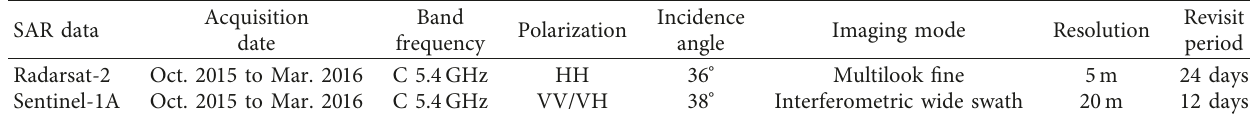
Figure 2: Wheat growth stage in Hebei study area from Oct. 2015 to Mar. 2016. (a) 13 Oct. 2015, (b) 6 Nov. 2015, (c) 24 Dec. 2015, (d) 17 Jan. 2016, and (e) 5 Mar. 2016. Table 1: Configuration parameters and acquisition time of multisensor SAR data.